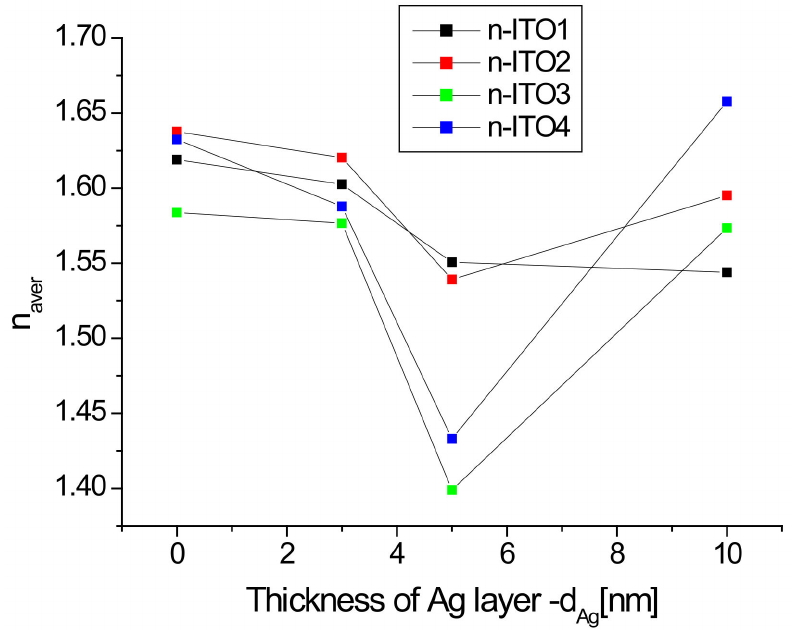
Figure 8. Dependence of the average refractive index in the visible region as a function of the Ag nanoparticle layer